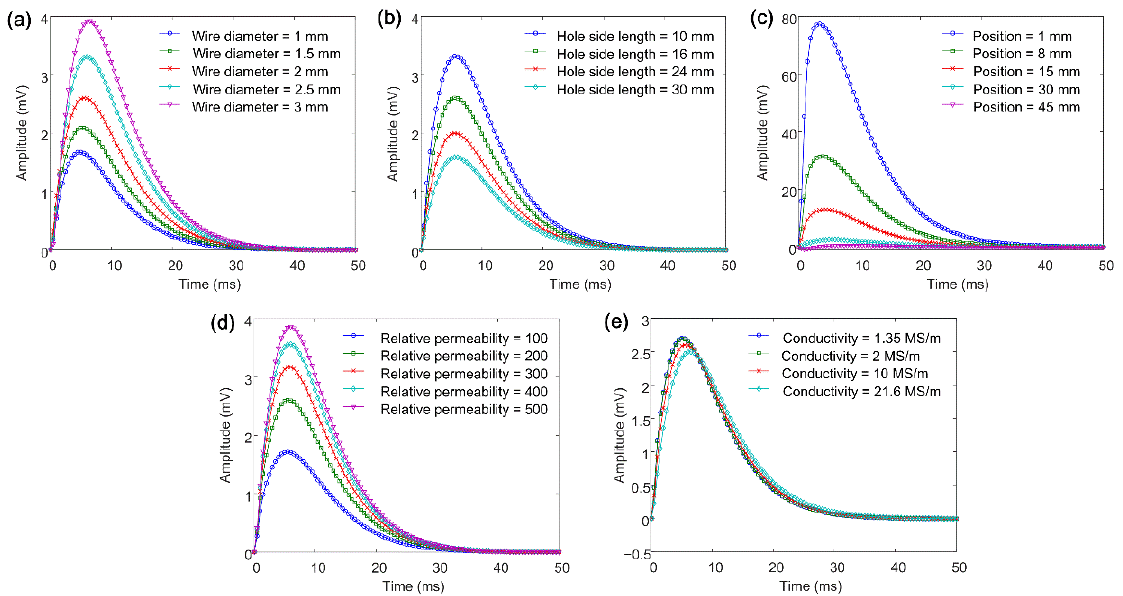
Figure 5. Simulated differential signals for variations in the ( a ) wire diameter, ( b ) hole side length, ( c ) position, ( d ) relative permeability, and ( e ) conductivity of the mild steel mesh.